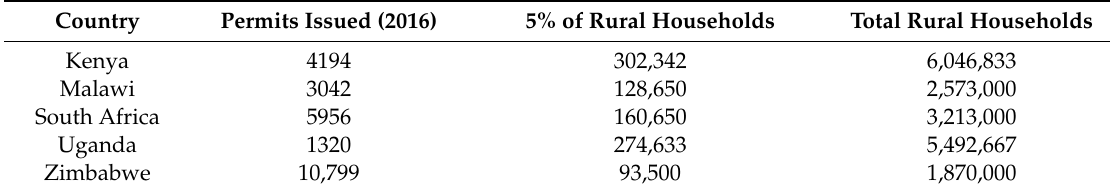
Table 1. Number of permits issued (2016) relative to the estimated number of small-scale users requiring permits based on an assumption of 5% of rural households requiring